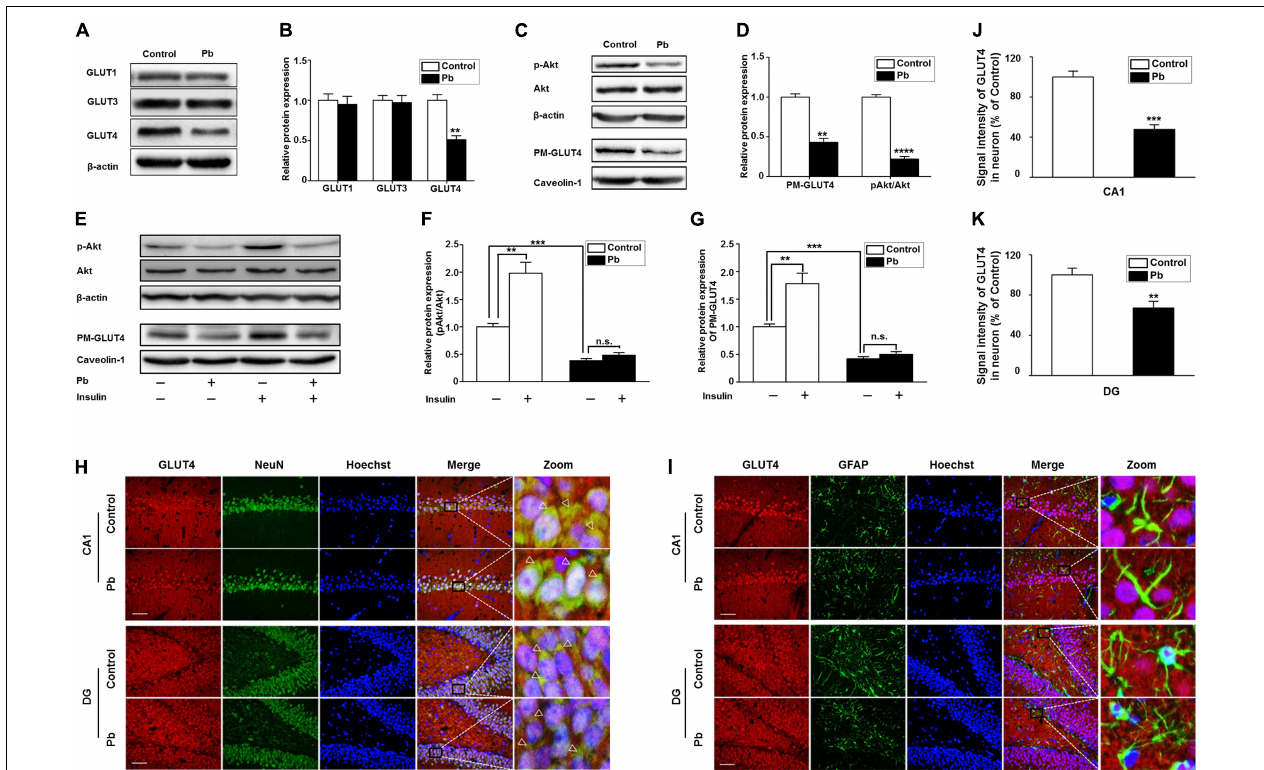
FIGURE 4 | Effects of Pb exposure on GLUT4 expression and membrane translocation in rat hippocampus. (A–D) Effects of Pb exposure on the expression of GLUTs, PM-GLUT4, and p-Akt. There were no remarkable changes in GLUT3 and GLUT1 expression in Pb-exposed rat hippocampus, but the GLUT4 expression was significantly reduced. The expression levels of PM-GLUT4 and p-Akt were significantly reduced. Among them, caveolin-1 served as the loading control of PM-GLUT4, and β -actin for other proteins. (E–G) Effects of insulin on PM-GLUT4 and p-Akt expression levels. Insulin stimulation significantly increased the expression of p-Akt in rat hippocampus but did not reverse the decrease of p-Akt expression in the Pb-exposed group. N = 6 per group, ** p < 0.01, *** p < 0.001, **** p < 0.0001. vs. control. The band intensity was statistically analyzed based on the percentage relative to the control. (H,I) Immunofluorescence staining. (J,K) Statistical results of signal intensity of GLUT4 expression in neuron in CA1 and DG regions of the hippocampus in rats. The results showed that GLUT4 and NeuN were significantly double-labeled in the CA1 and DG regions of the hippocampus in rats, and double-labeling in the Pb-exposed group was significantly reduced compared to the control group levels. Immunofluorescence staining indicated that GLUT4 and GFAP were not double-labeled in the hippocampal CA1 and DG regions of rats. Scale bars = 50 µ m. Data were represented as mean ± SEM and counted based on data from a minimum of three independent experiments, ** p < 0.01, *** p <